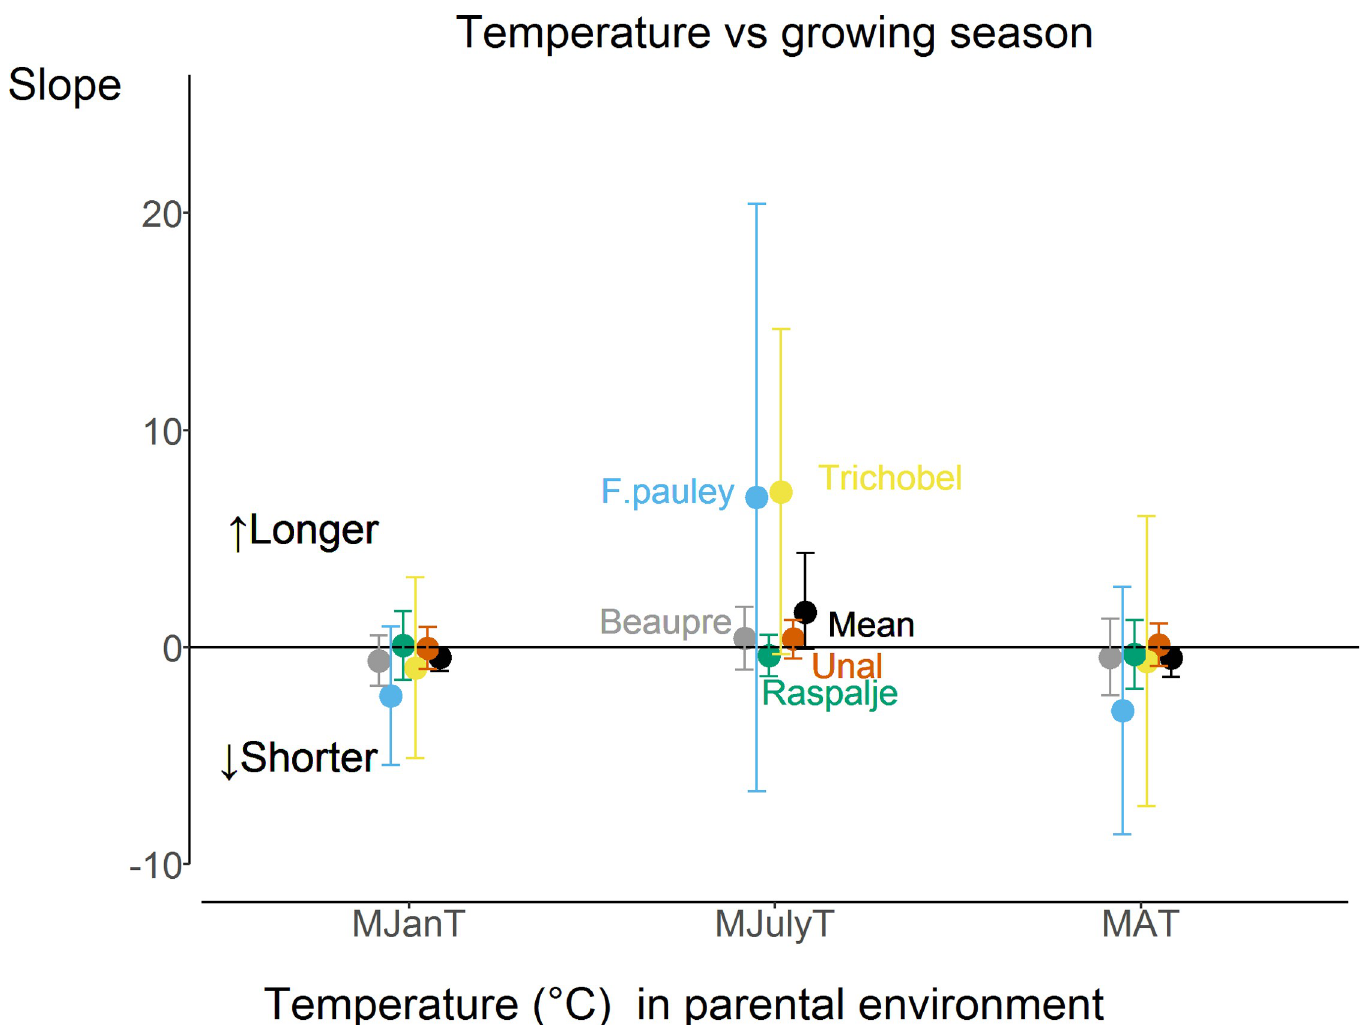
Fig 3. Slopes of the relationship between the length of growing season of five genotypes (Beaupre, Fritzy Pauley, Raspalje, Trichobel and Unal) in 2015 and mean January, July and annual temperatures experienced by the parent trees. Mean weighted (bootstrapped) slopes are indicated by black points and error bars denote 95% confidence intervals (upper and lower) across 500 bootstrapped values. Error bars denote 95% confidence intervals. ‘Shorter’ means that growing season is shorter with increasing temperature and ‘Longer’ means that growing season is longer with increasing temperature.